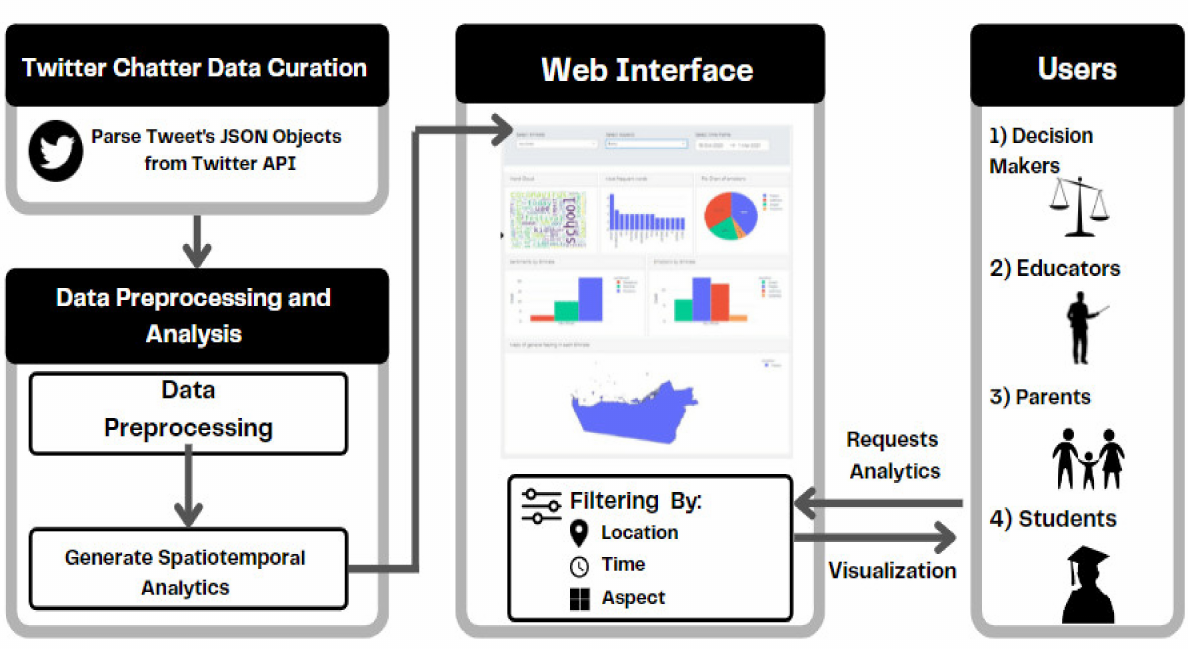
Figure 1. The proposed analytics framework